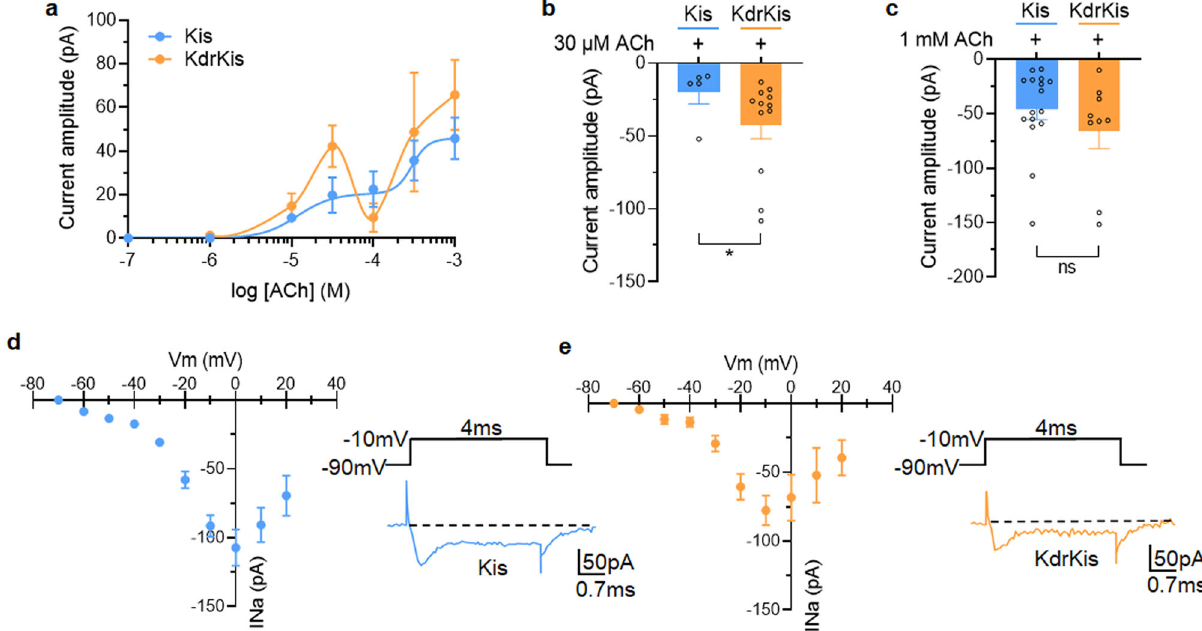
Fig. 6 Acetylcholine has different effects on nAChRs in neurons isolated from Anopheles gambiae KdrKis strains. a Superimposed semilogarithmic dose-response curves for the ACh-induced currents recorded at a holding potential of − 50mV in isolated neurons from mosquito strains Kis and KdrKis, as indicated on the graph. Note that for concentration lower than 100 µ M (i.e., 30 µ M), ACh produced higher current amplitude than in Kis neurons. Data are mean ± S.E.M. ( n = 3 – 16). b , c Comparative histogram showing the effects of pulse application of ACh (3 s in duration) tested at 30 µ M ( b , n = 5 and n